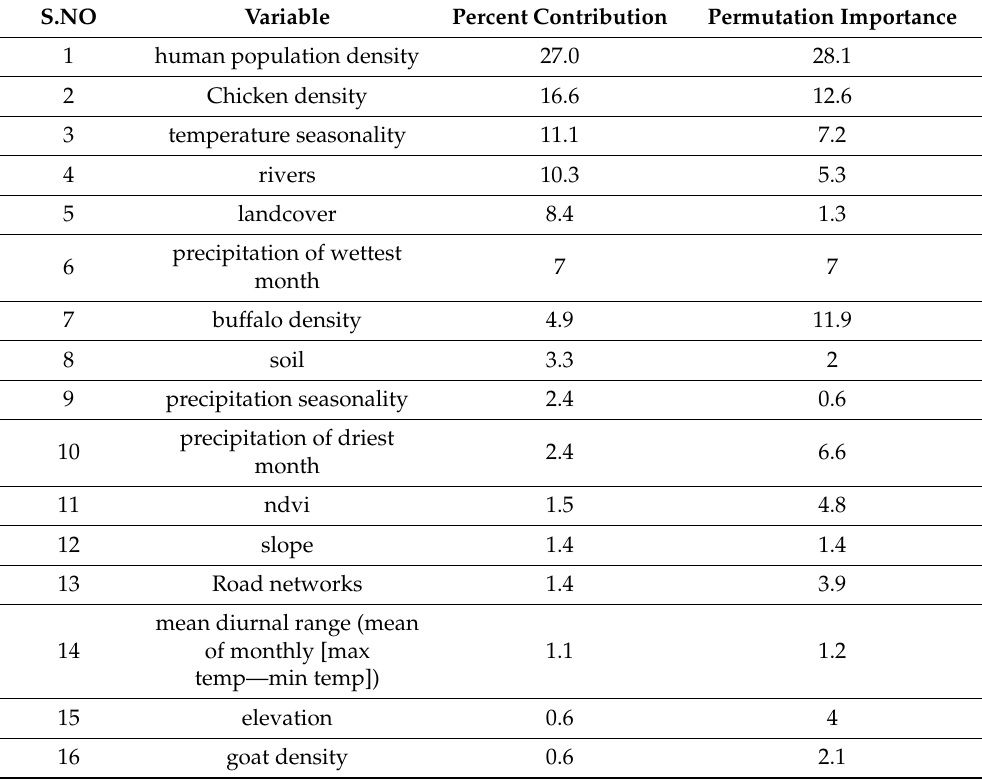
Table 2. Percent contribution of variables in determining suitable habitat of steppe eagle in Pakistan.